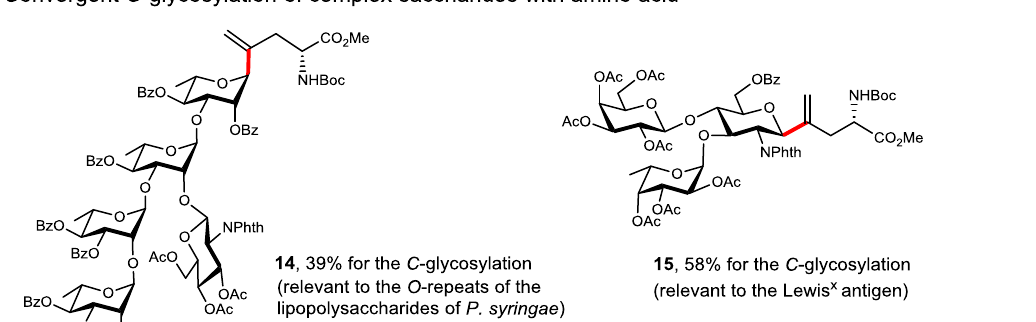
Fig. 8 Scale-up reaction, subsequent transformation, and C -glycosylation with complex saccharides. a A gram-scale synthesis of C -glycosyl amino acid and subsequent transformations. Conditions and reagents: A. NiCl 2 (DME) (10 mol%), dtbbpy (15 mol%), (R) -Tol-BINAP (6.0 mol%), PMHS (2.5 equiv.), Na 2 CO 3 (2.5 equiv.), THF (0.1 M), 25 – 28 °C, Ar, 48 h, 65%. B. i) 80% N 2 H 4 ·H 2 O, MeOH, 0 °C, 9 h; ii) HOAc/MeOH (1/4, v/v), 70 °C, 1.5 h; iii) Ac 2 O, Et 3 N, CH 2 Cl 2 , 6 h, 60% over three steps. C. i) HF·pyridine, pyridine, 0 °C → rt, 2 h, 85%; ii) Au(PPh 3 )NTf 2 (10 mol%), 4 Å MS, CH 2 Cl 2 , 0 °C → rt, 0.5 h, 81%. D. i) CH 2 Cl 2 /TFA (2/1, v/v), 0 °C → rt, 1.5 h; ii) N -Cbz- O - t Bu-L-serine (1.5 equiv.), HOBt (1.5 equiv.), DIPEA (4.0 equiv.), EDCI (1.5 equiv.), DMF, -10 °C →